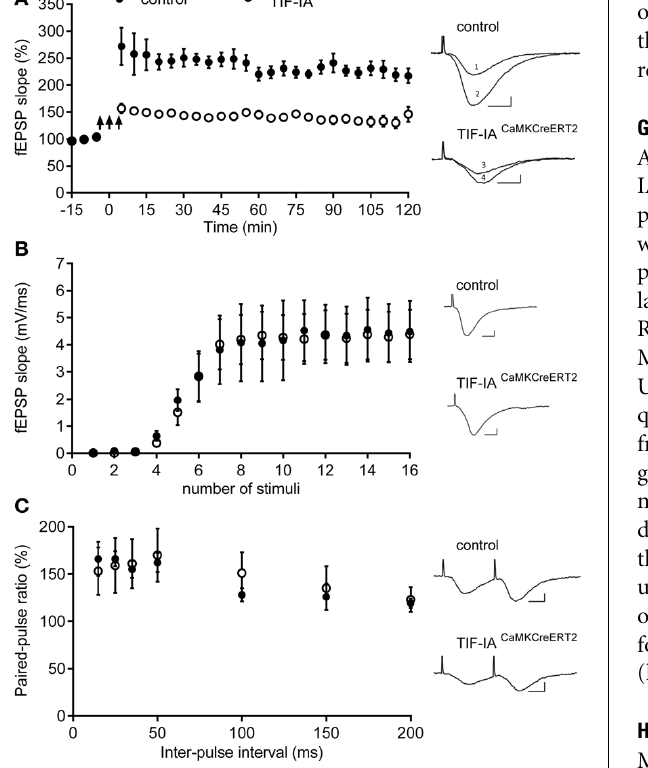
35, 50, 100, 150, and 200 ms and stimulus intensity